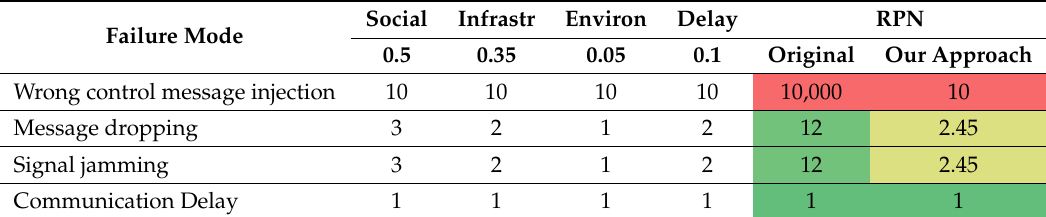
Table 12. Risk Priority Number